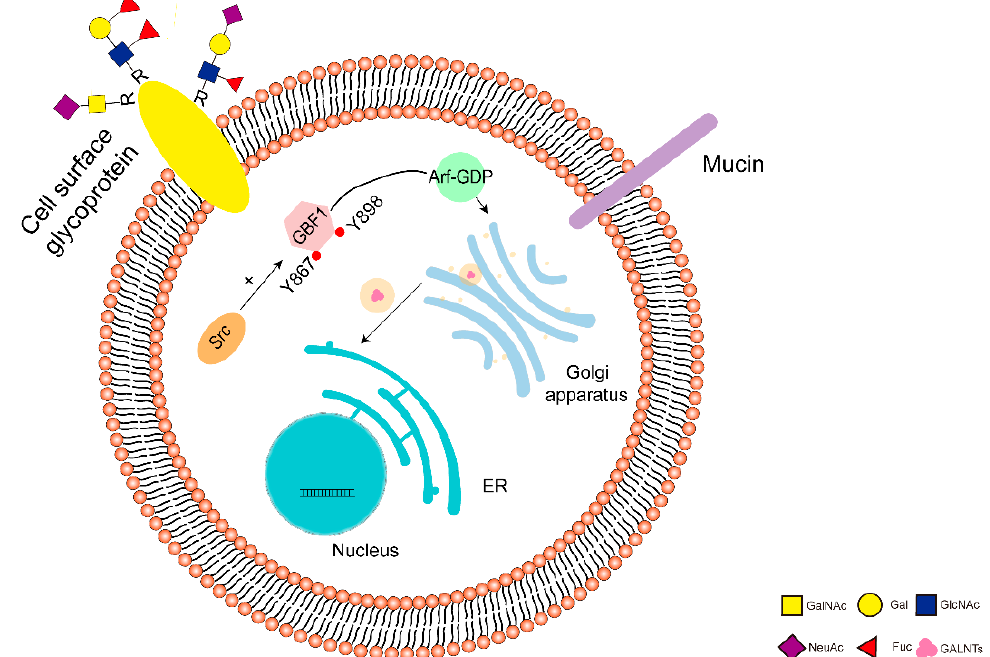
Figure 2. Src facilitates the relocalization of GALNTs from Golgi to ER by promoting the binding of GBF1 to Arf1. The transfer of GALNTs from Golgi to ER is called “GALA pathway”, which is essential for tumor growth. The transport of GALNTs from Golgi to ER is dependent on the GTP exchange factors GBF1 and Arf-GDP, Src induces the formation of tubular transport carriers containing GALNTs and also phosphorylates GBF1, where phosphorylation of two sites on GBF1, Y876, and Y898, and facilitates the binding of GBF1 to Arf-GDP. This led to the efflux of GALNTs from the Golgi membrane and their eventual relocalization to the